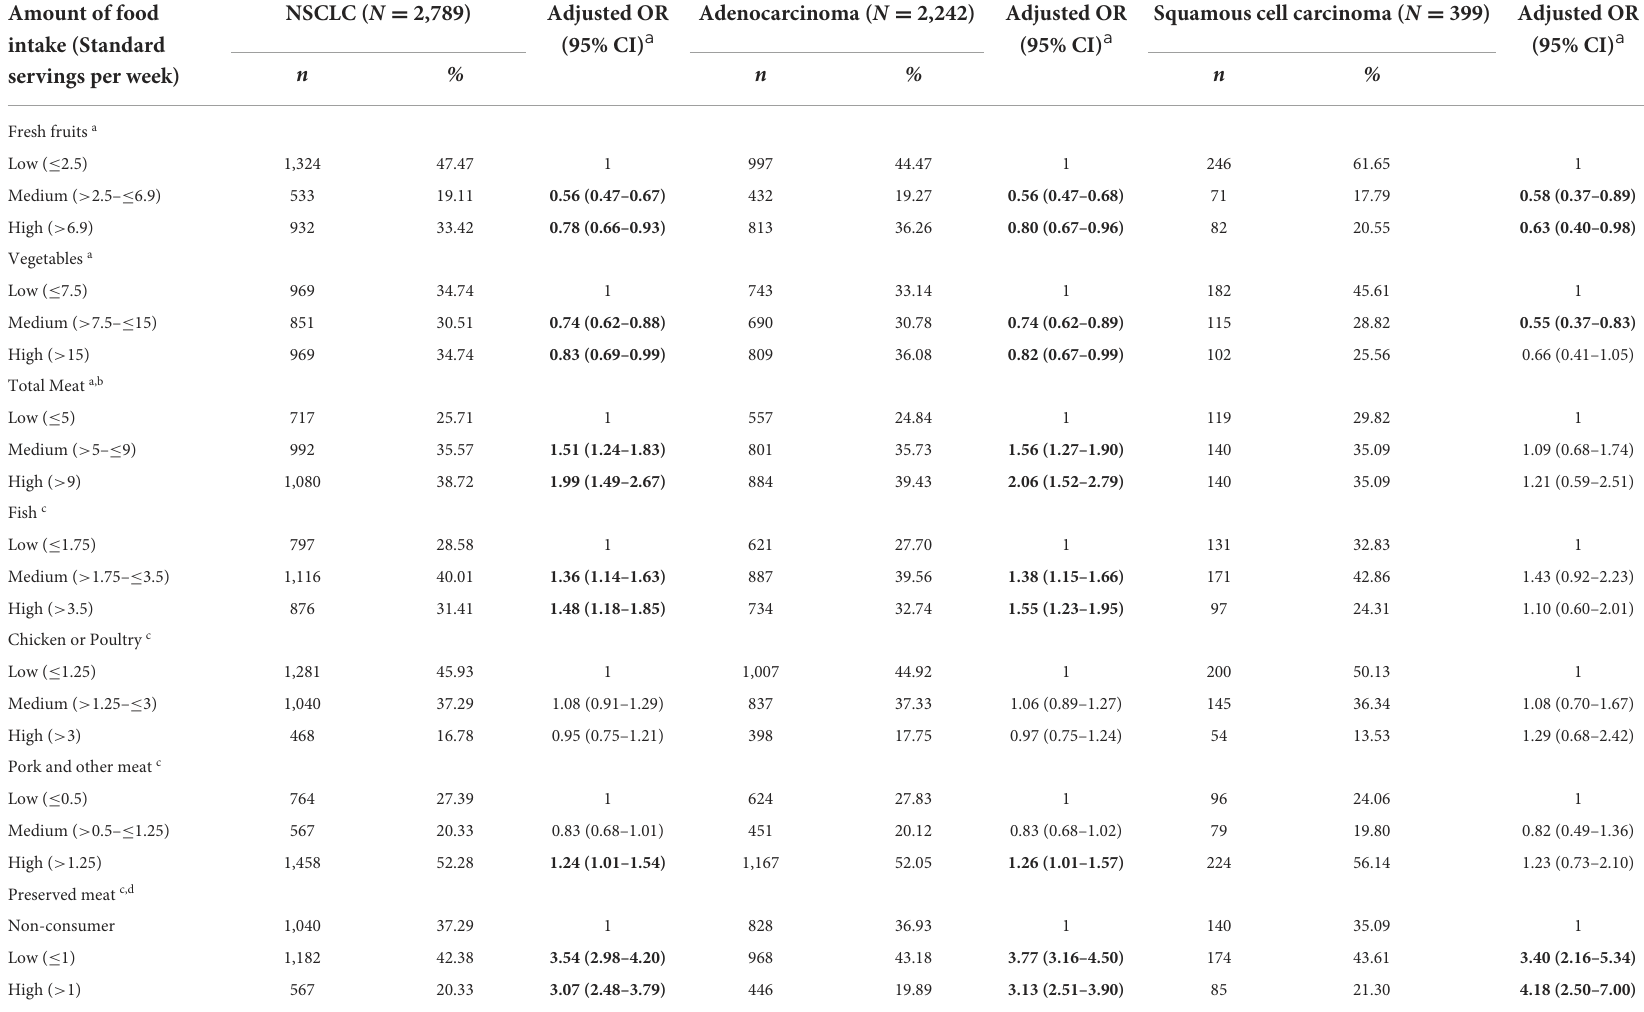
TABLE 3 Association between consumption of fruits, vegetables, and meat with risk of different histologic types of lung cancer. Amount of